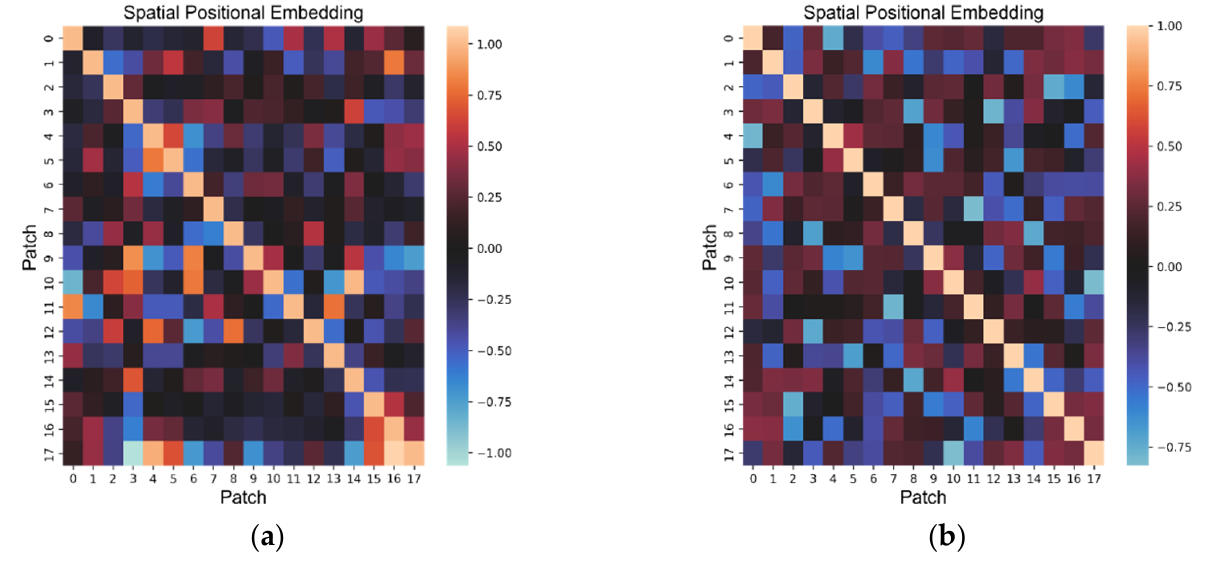
Figure 9. Cosine similarity of spatial position embedding. ( a ) The left side shows the position embedding for the encoder block. ( b ) The right side shows position embedding for the decoder block.